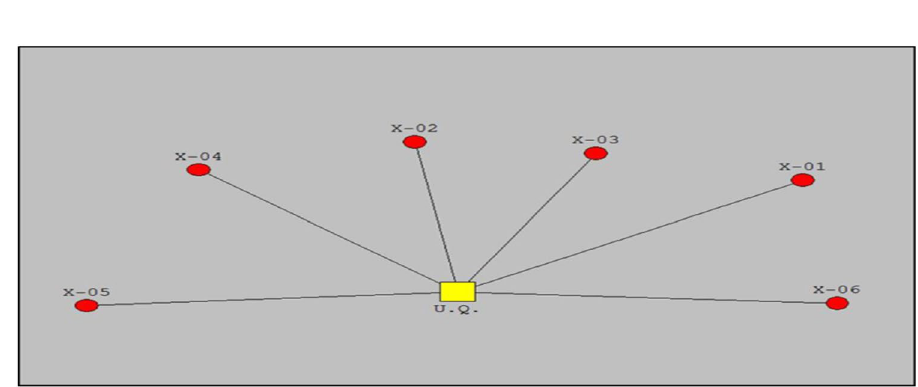
Fig. 8 Material balance model: reservoir tank and six